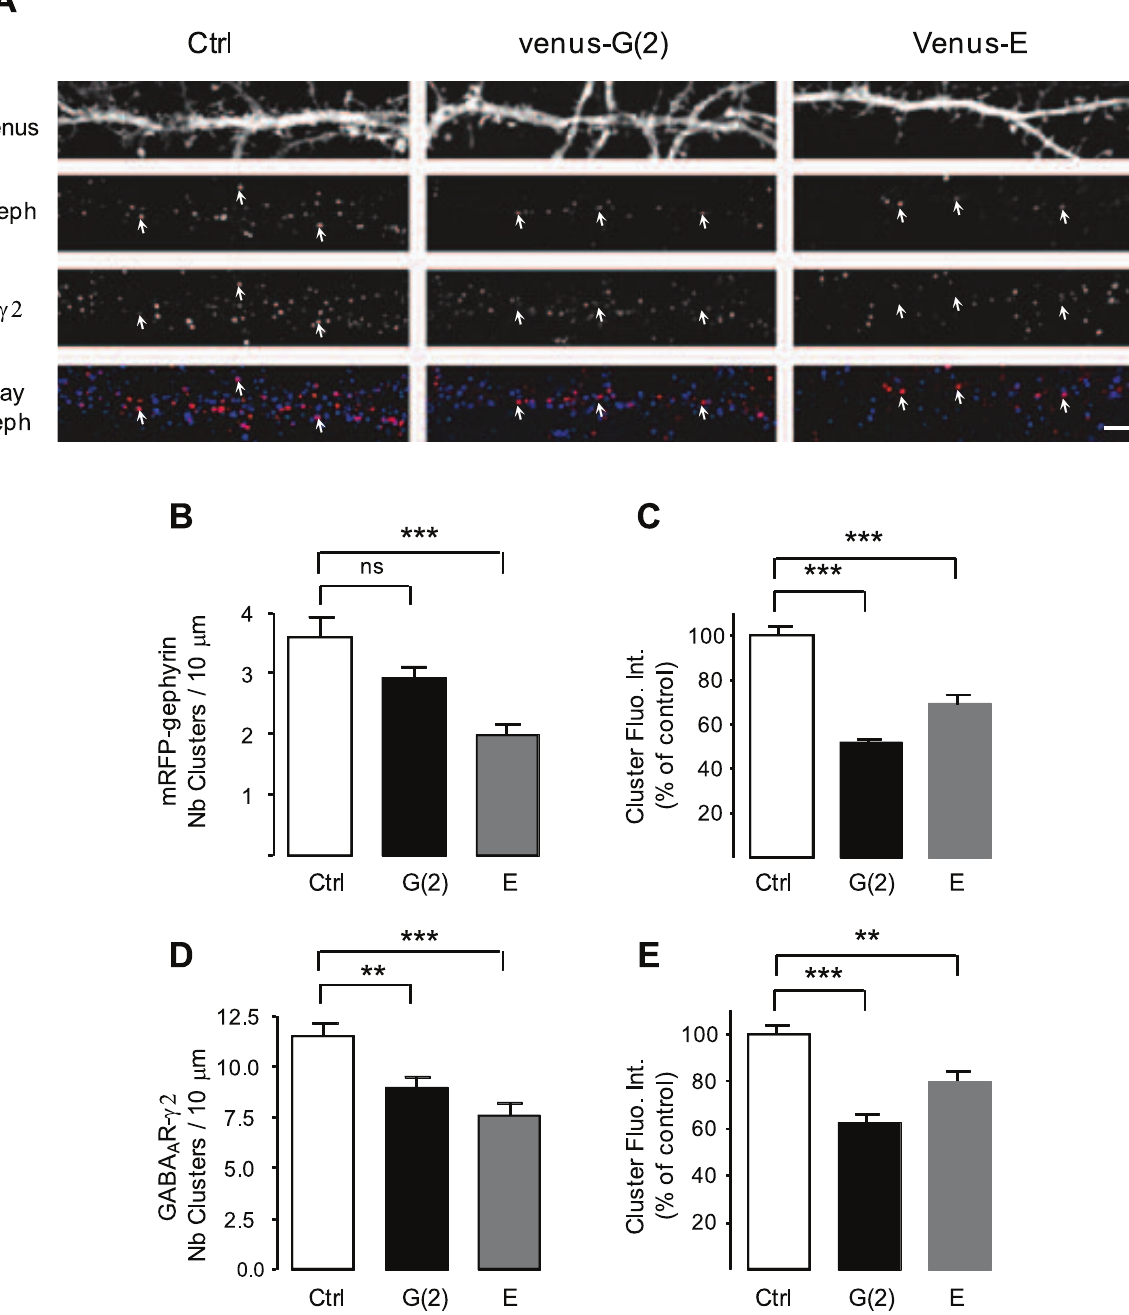
Figure 5. Gephyrin dominant-negative chimera decreased gephyrin and GABA A R c 2 clustering. (A) Hippocampal cultured neurons from mRFP-gephyrin knock-in mice transfected with GFP, venus-G(2), or venus-E constructs, and stained for c 2. Scale, 2 m m. Note that mRFP-gephyrin and GABA A R c 2 formed numerous clusters along dendrites of GFP transfected neurons. Many mRFP-gephyrin clusters were colocalized with GABA A R c 2 clusters (arrows). Over-expression of the venus-G(2) and venus-E chimera resulted in a marked reduction of the number and intensity of mRFP- gephyrin and GABA A R c 2 clusters. The remaining mRFP-gephyrin clusters were rarely colocalized with c 2 clusters (arrows). (B-E) Quantifications showing venus-G(2) and venus-E constructs reduced both the number of gephyrin (B) and c 2 (D) clusters per 10 m m dendritic length and the fluorescence intensity of the corresponding clusters (C, E). Values are mean 6 SEM. t-test, ns: not significant, **: p , 0.01; ***: p , 10 2 3 . doi:10.1371/journal.pone.0043032.g005 interacting only transiently with the scaffold. Indeed, we found condition the average behavior of QDs. Moreover, the changes in that only , 30% of GABA A R c 2 and , 15% of GluA2 were mobility resulting from the transitions between states such as trapped at inhibitory synapses and excitatory synapses respective- bound and unbound to a scaffolding element can be difficult to ly. The predominance of passing receptors at synapses thus identify with the classical MSD analysis (refs in [47]). Therefore,